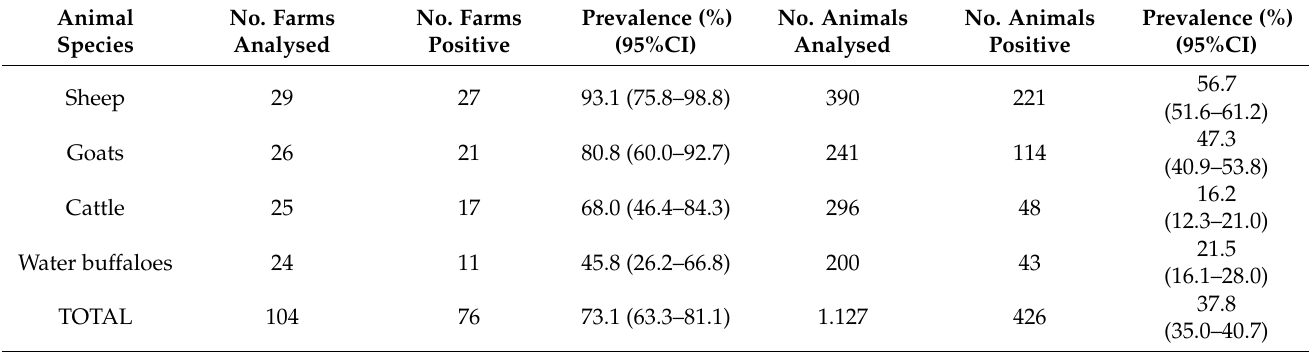
Figure 2. Distribution of T. gondii in the livestock farms analysed according to animal species: ( A ) sheep; ( B ) goats; ( C ) cattle and ( D ) water buffaloes. Table 1. Overall seroprevalence of T. gondii at farm and animal level according to animal species (sheep, goats, cattle and water buffaloes).